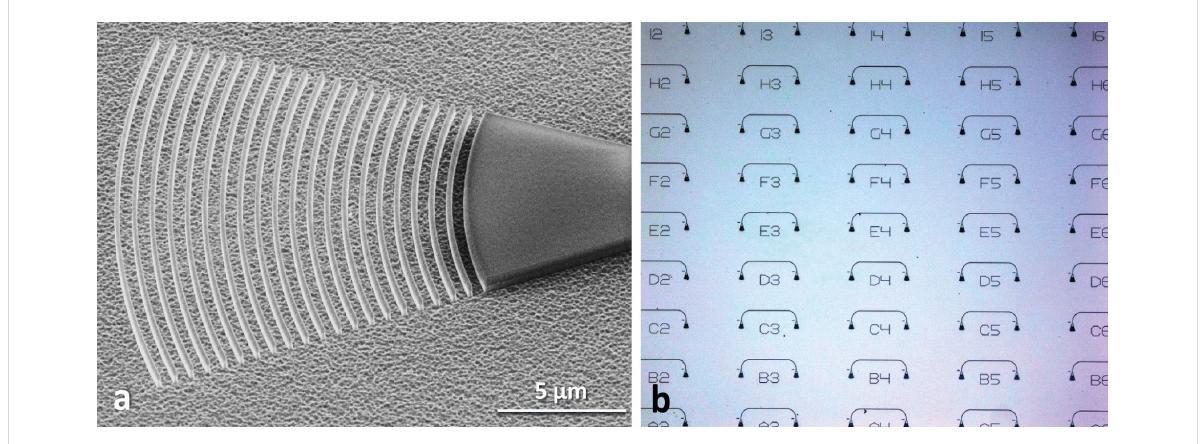
Figure 2: (a) SEM image of a fabricated focussing grating coupler. Light propagating through the incoming waveguide is scattered out of plane and collected by an optical fibre aligned to the grating section. (b) Optical microscope image of a fabricated chip containing several grating couplers connected by nanophotonic waveguides. The circuits enable characterization of the transmission profile of the grating couplers.